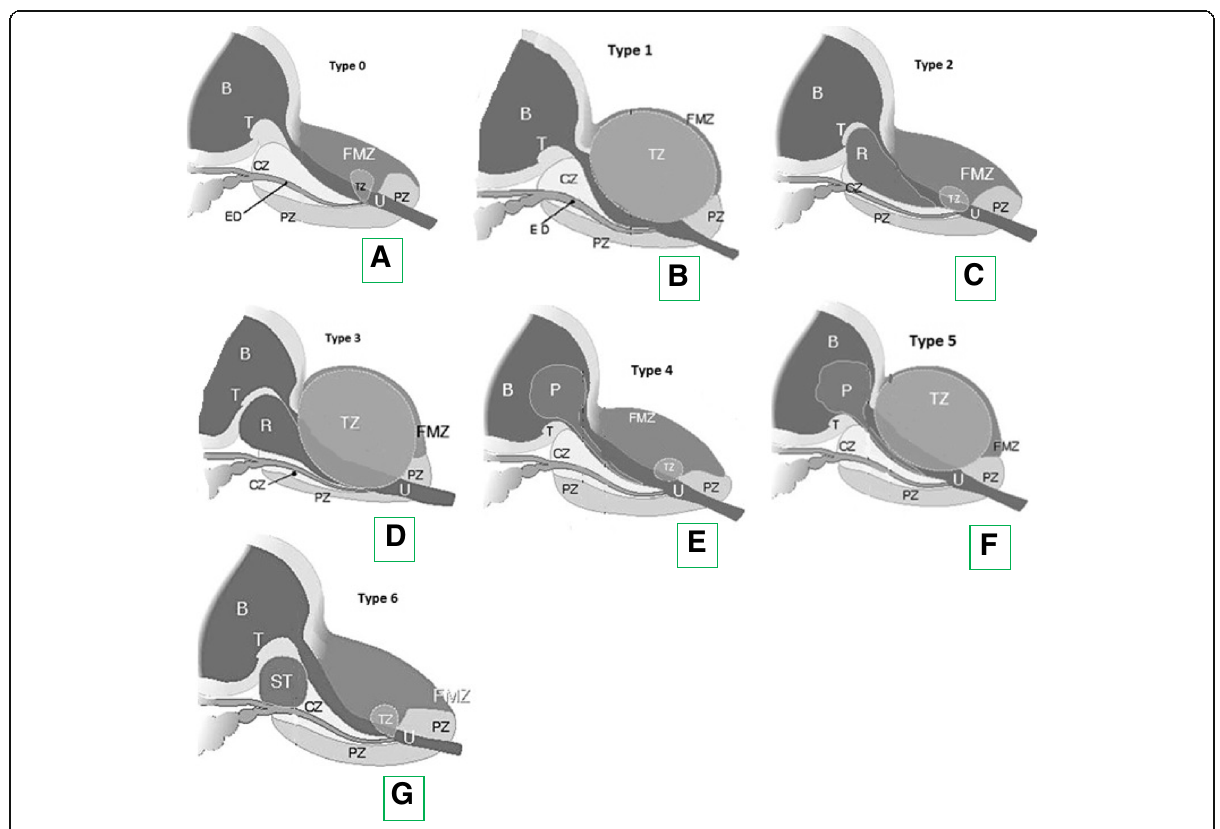
Fig. 3 BPH types are as follows: a type 0 BPH; normal prostate volume with no or little zonal enlargements. b Type 1 BPH; transition zone (TZ) (lateral lobe) enlargement. c Type 2 BPH; retrourethral (median) lobe enlargement (R). d Type 3 BPH; transition zone (TZ) and retrourethral zone (R) enlargement. e Type 4 BPH; pedunculated adenoma. f Type 5 BPH; pedunculated adenoma with transition zone (TZ) enlargement. g Type 6 BPH; subtrigonal enlargement. B, bladder; ED, ejaculatory duct; FMZ, fibromuscular zone; R, retrourethral (median) lobe; T, trigone; U, urethra; PZ, peripheral zone; TZ, transitional zone; CZ, central zone; P, pedunculated adenoma; ST, subtrigonal maximum flow rate ( Q ) to generate three Q max max ˃ 15 ml/s), equivocal grades: unobstructed flow ( Q max flow ( Q 10 – 15 ml/s), and obstructed flow ( Q < 10 max max ml/s) [12].